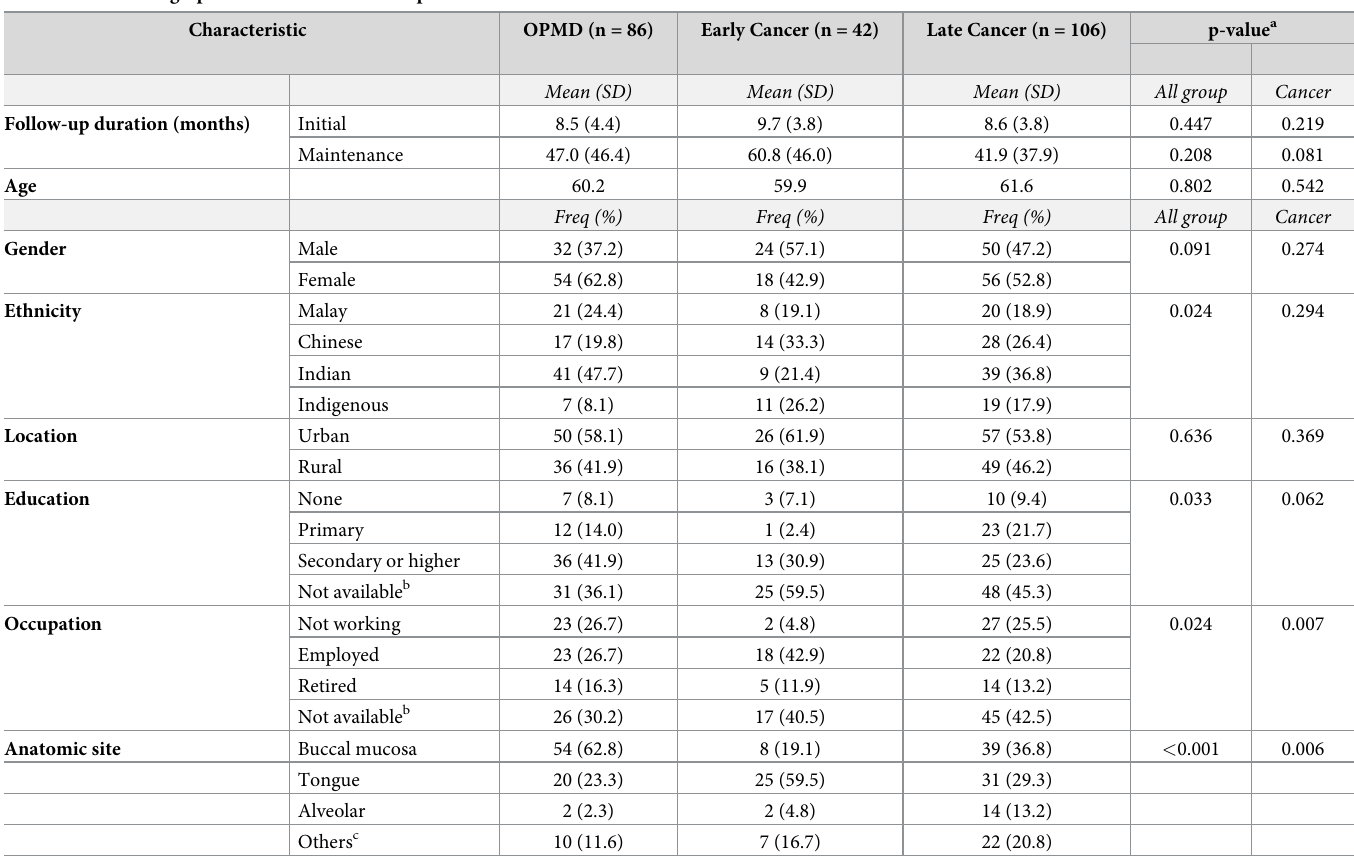
Table 1. Sociodemographic and clinical details of patients.